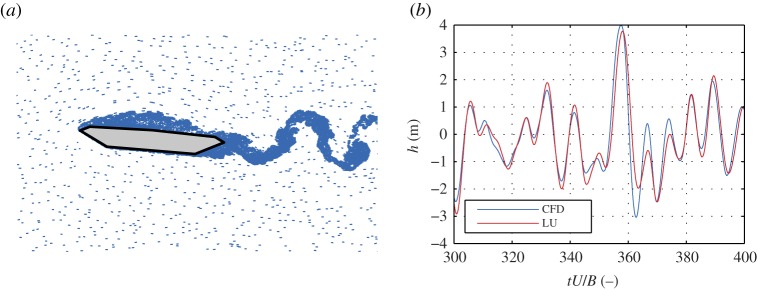
Sample particle map for the CFD model (a) at U = 40 m s−1 and the corresponding sample time history of the vertical displacements (b). The upstream particles simulate the free-stream turbulence.